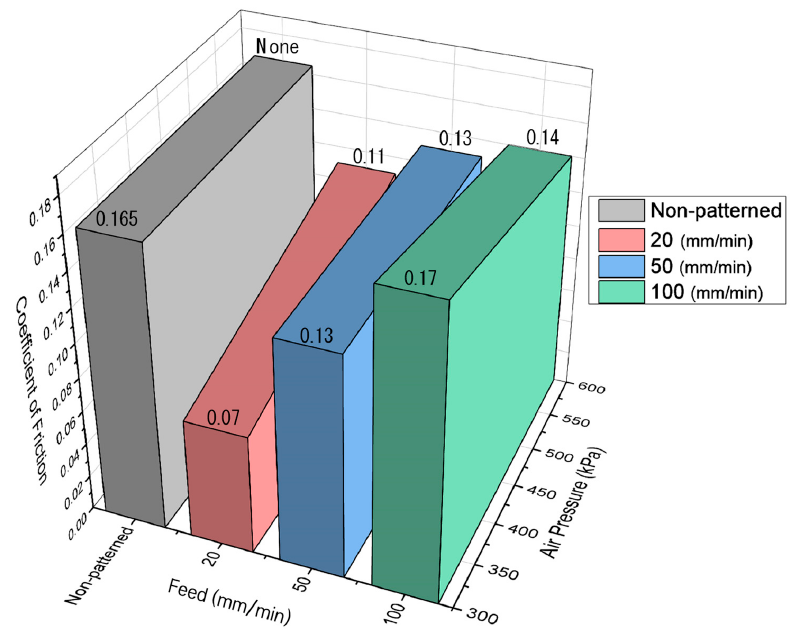
Figure 12. Coefficient of friction due to changes in traverse speed of the micro-AAJ nozzle during machining at 200 rpm.